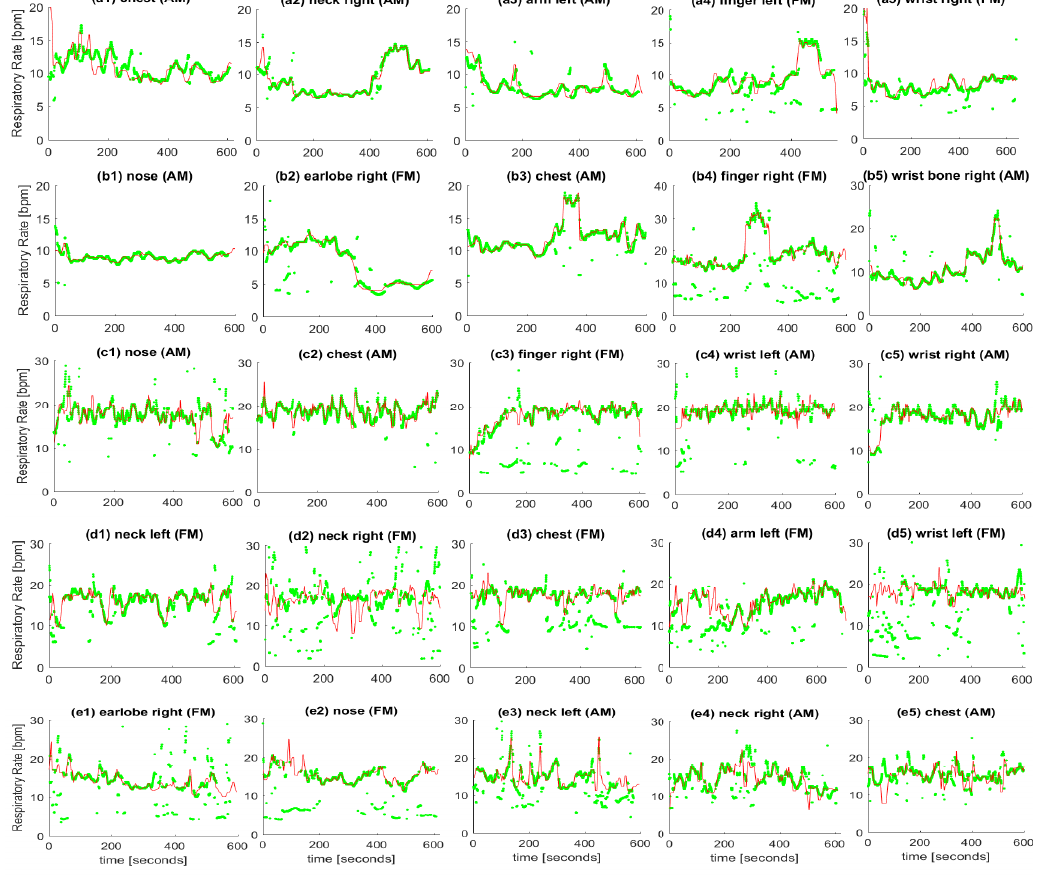
Figure 4. Reference respiratory rate (solid line with red color) and estimated instantaneous respiratory rate using the proposed method (green dots) from selected body position and respiratory induced modulation for subject #1 ( a1 – a5 ), subject #2 ( b1 – b5 ), subject #3 ( c1 – c5 ), subject #4 ( d1 – d5 ), subject #5 ( e1 – e5